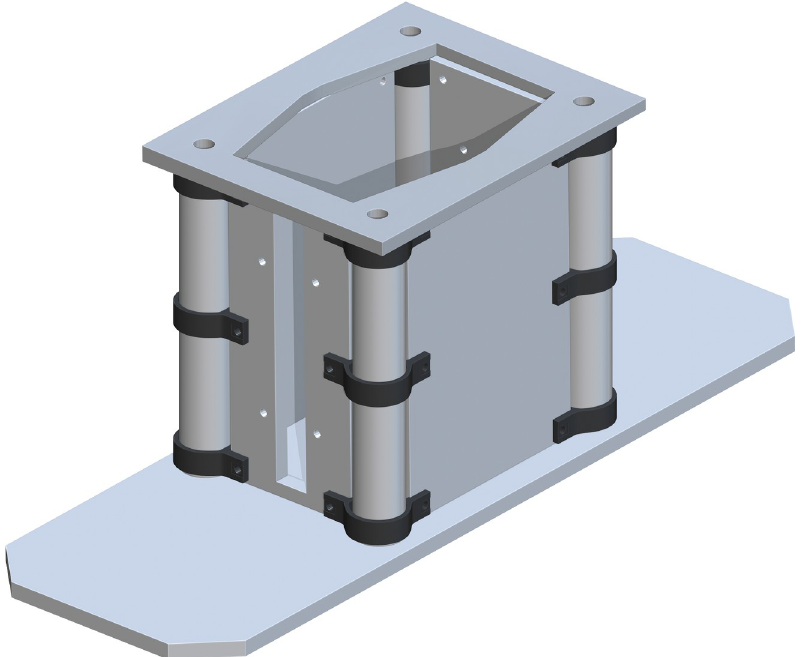
Fig 4. Addition of bottom of support structure to the